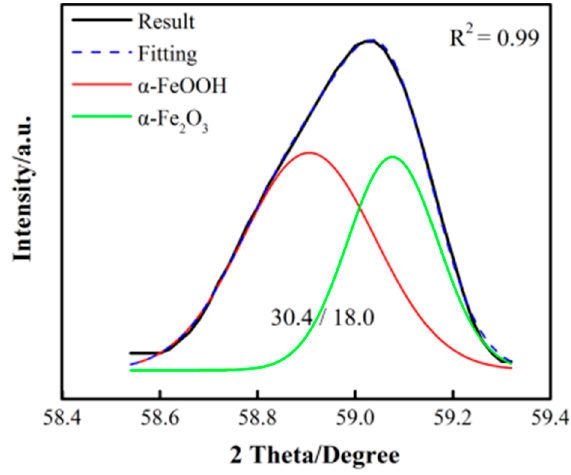
Figure 12. Fitting results using the peak splitting. Table 5. Crystalline phases of corrosion products of Q235 steel formed at different times.